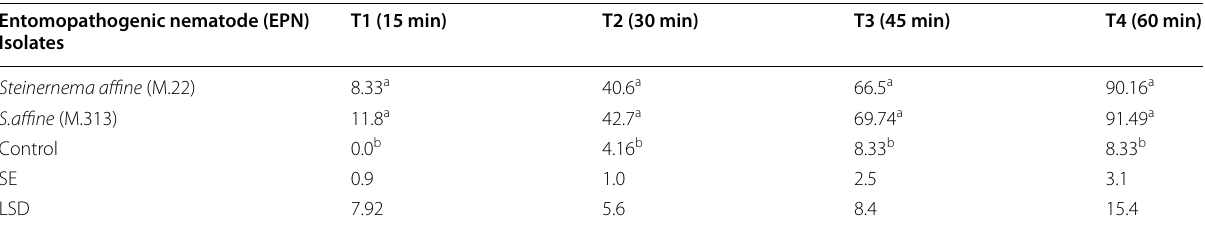
Table 4 Mortality of Galleria mellonella by Steinernema affine (M.22 and M.313) in the exposure time assay at ( P < 0.01) Entomopathogenic nematode (EPN)